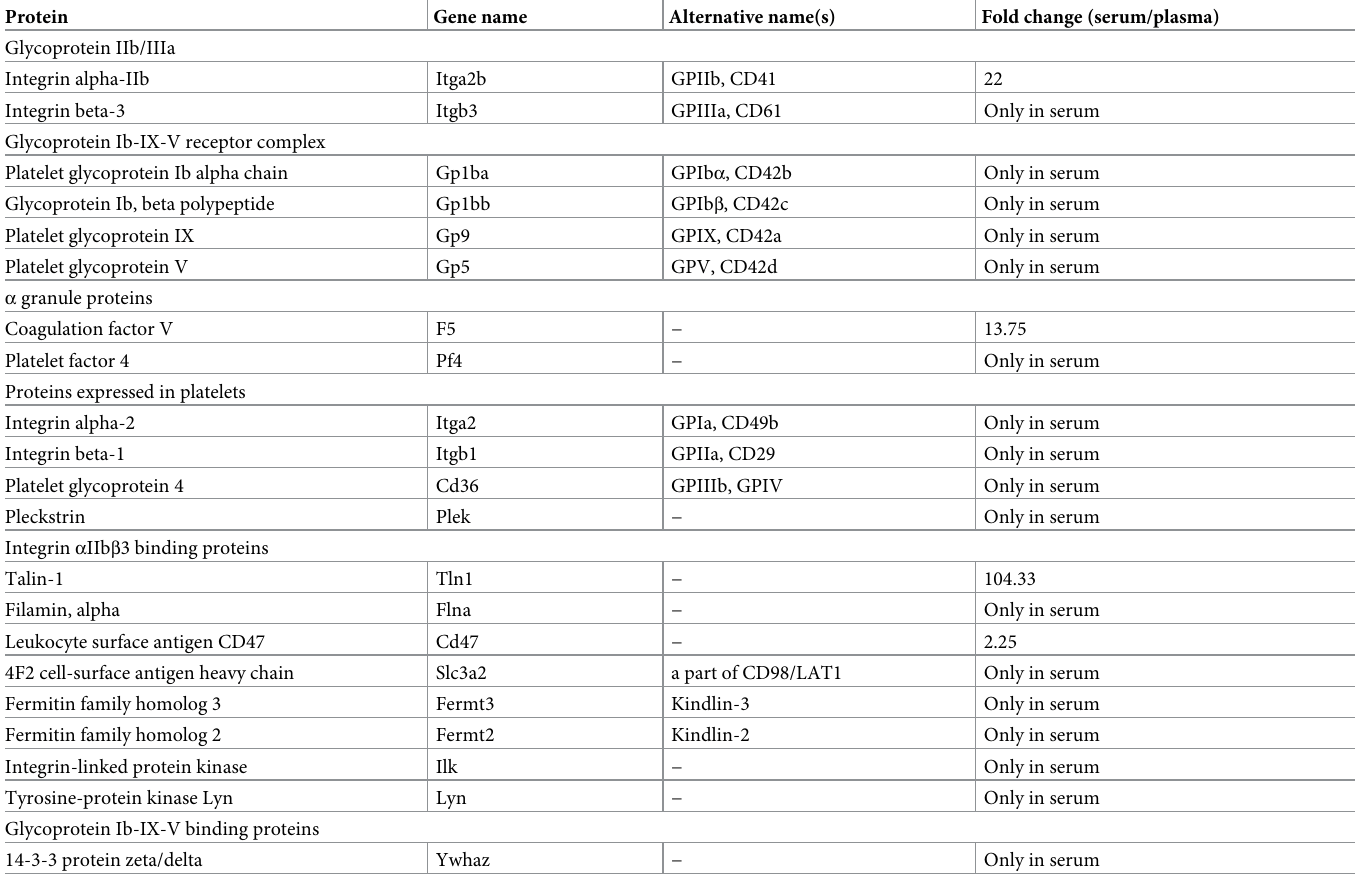
Table 1. Platelet-associated proteins detected in serum EVs.